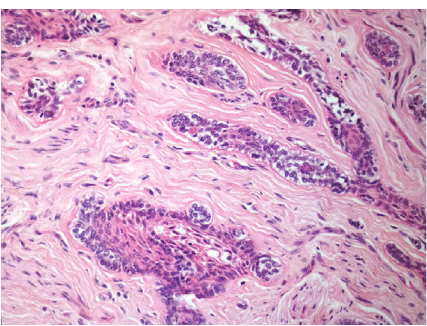
Figure 4: Histological aspect of the PA.